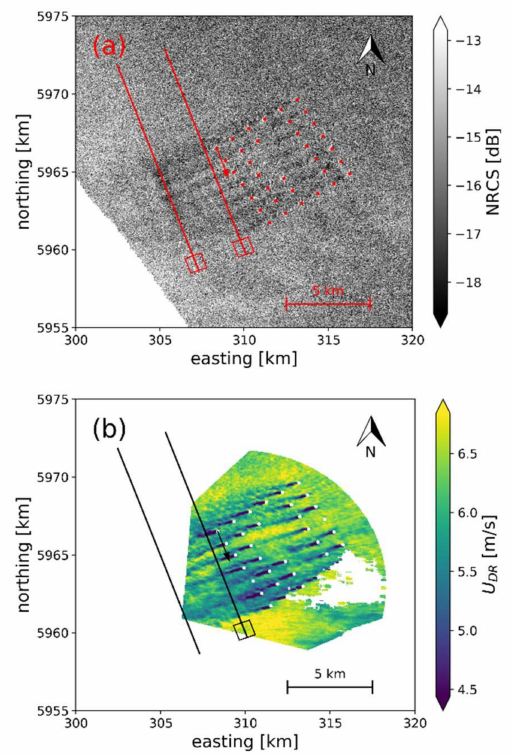
Figure 9. Case 3 (27-04-2018 at 17:04 UTC): ( a ) SAR backscatter image and ( b ) Doppler radar wind speed at 100